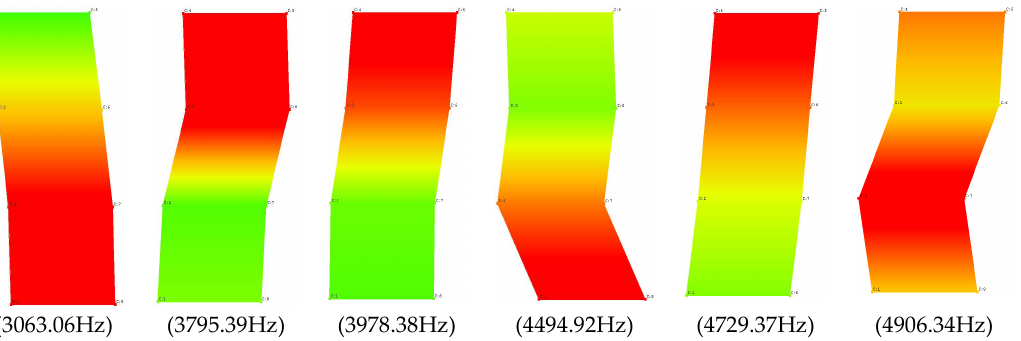
Figure 15. Natural frequency values of the damaged solid ceramic brick.